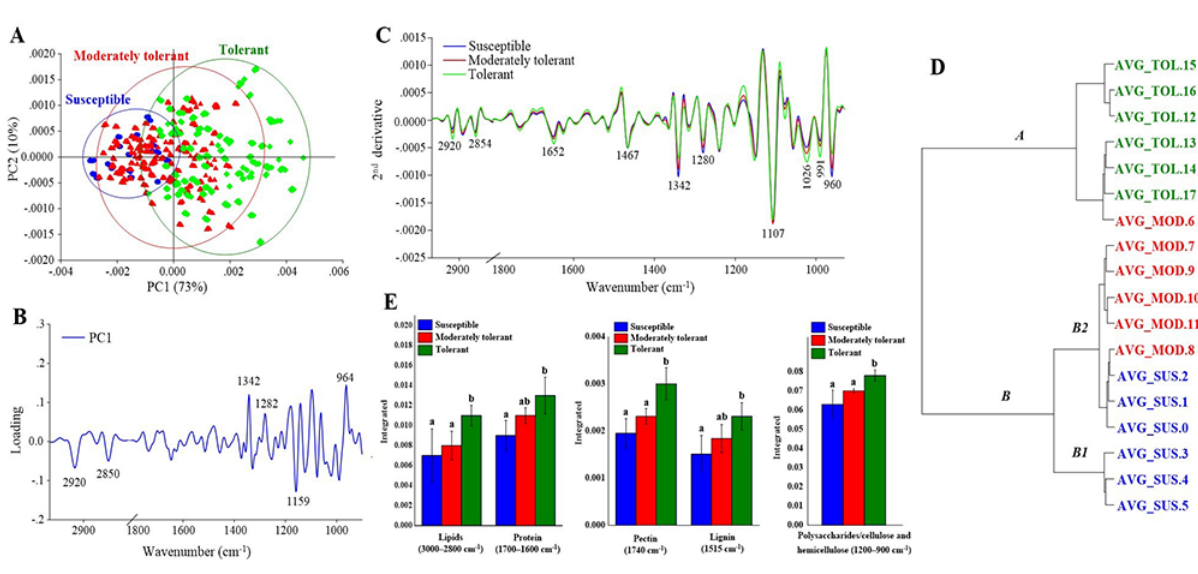
Figure 5 ( A ) Representative PCA score plot of susceptible, moderately tolerant and tolerant plants under drought stress conditions. ( B ) Loading plot of PC1 from the PCA. ( C ) second-derivative-transformed spectra. ( D ) Comparisons of the integrated areas of the biochemical components of plants from each drought stress condition. ( E ) HCA (via Ward’s algorithm) results aer second-derivative transformation and vector normalization of the spectra. e obtained spectra were analyzed in the regions of 3,000–2,800 cm − 1 and 1,800–900 cm − 1